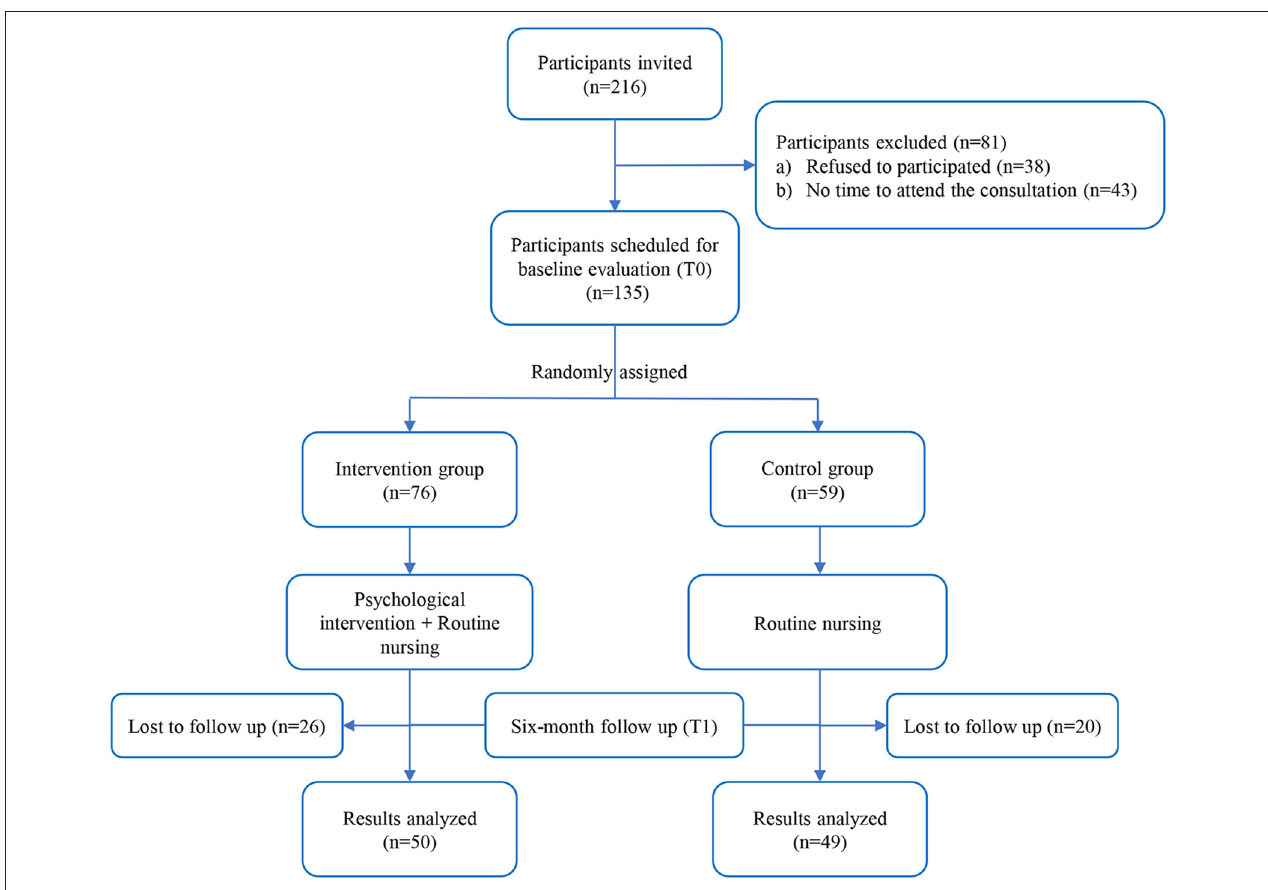
FIGURE 1 | Flow diagram of the study, included and